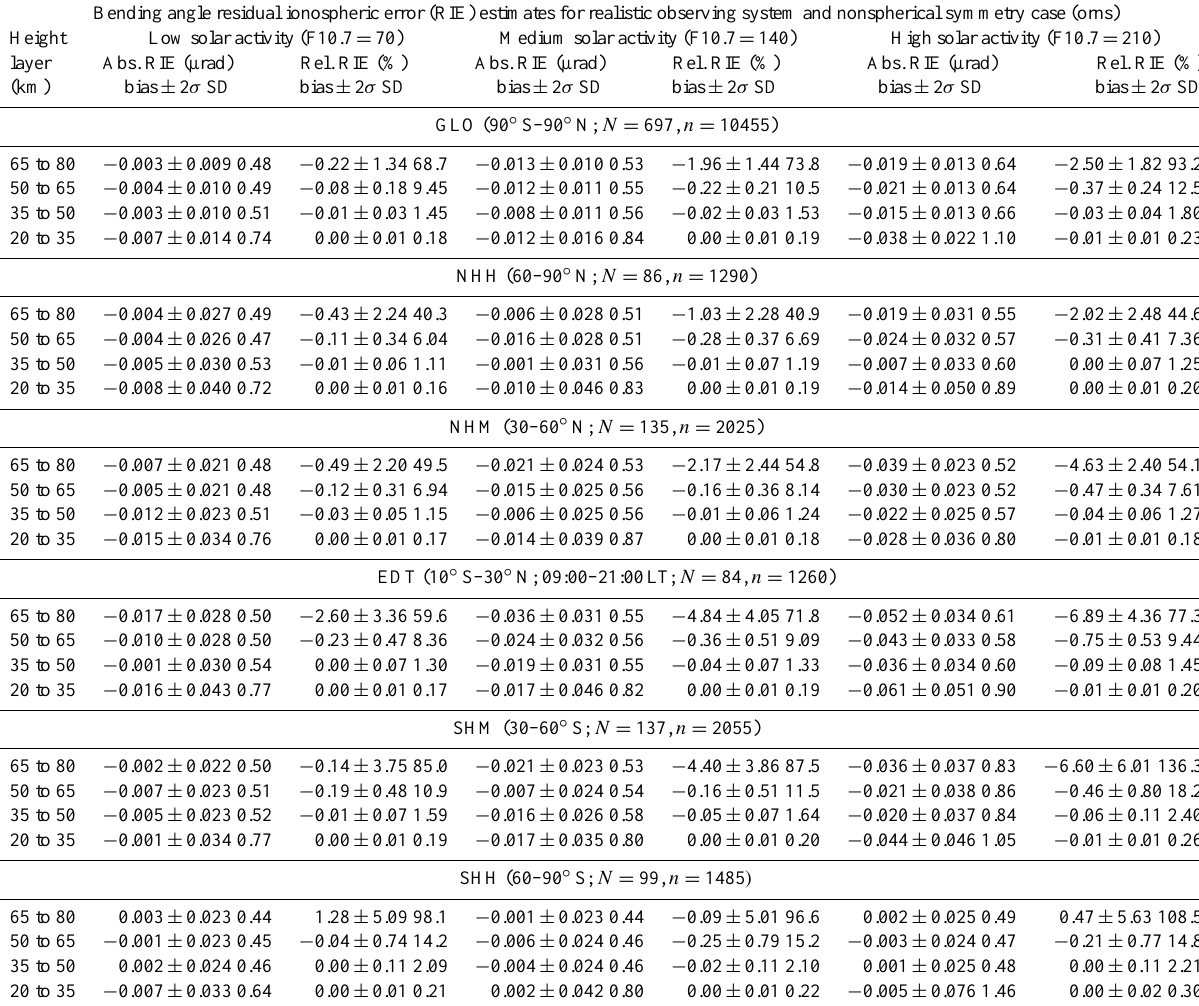
Table 7. Absolute and relative biases, including their 2 σ (95%) confidence ranges, and absolute and relative standard deviations of bending angle RIEs in the same layout as in Table 4 but for the orns